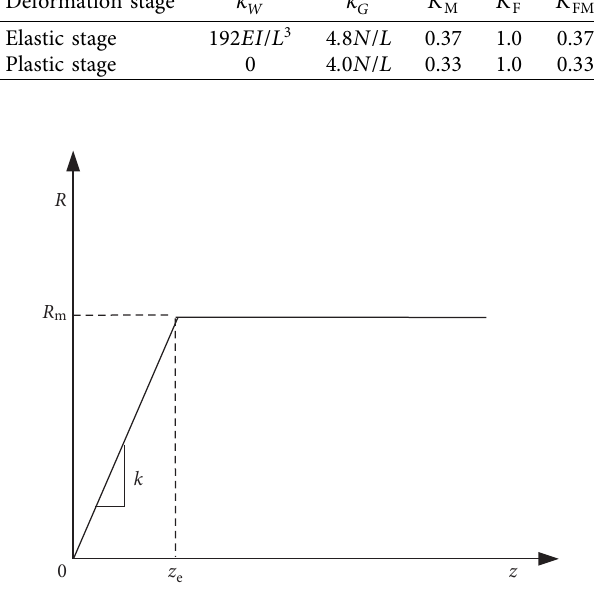
Figure 7: Bilinear resistance function model for the SDOF